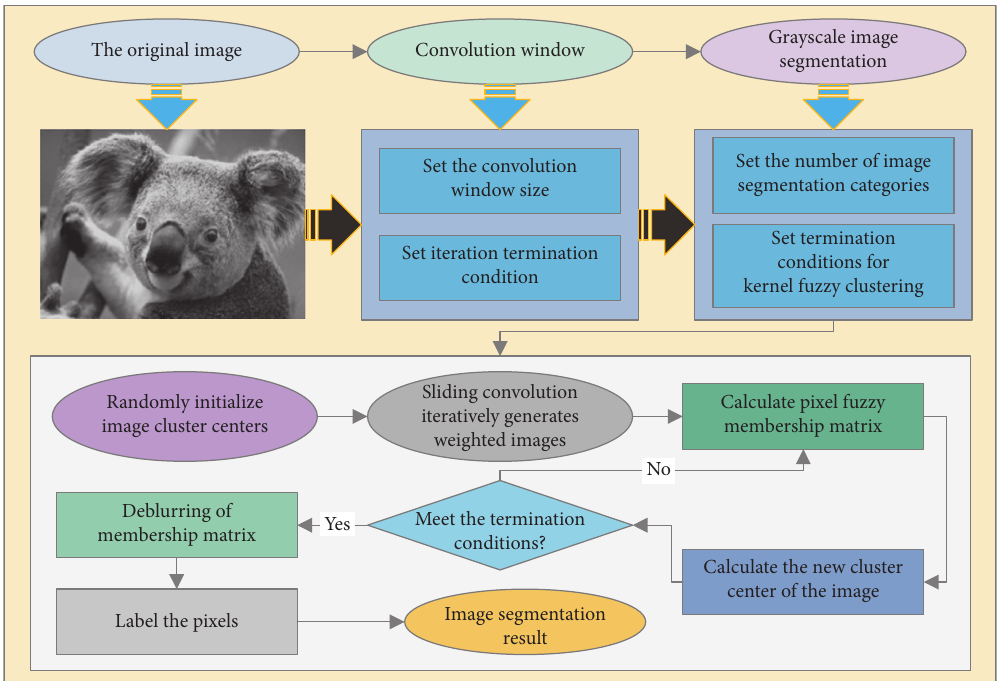
Figure 1: Flowchart of the grayscale image segmentation algorithm.